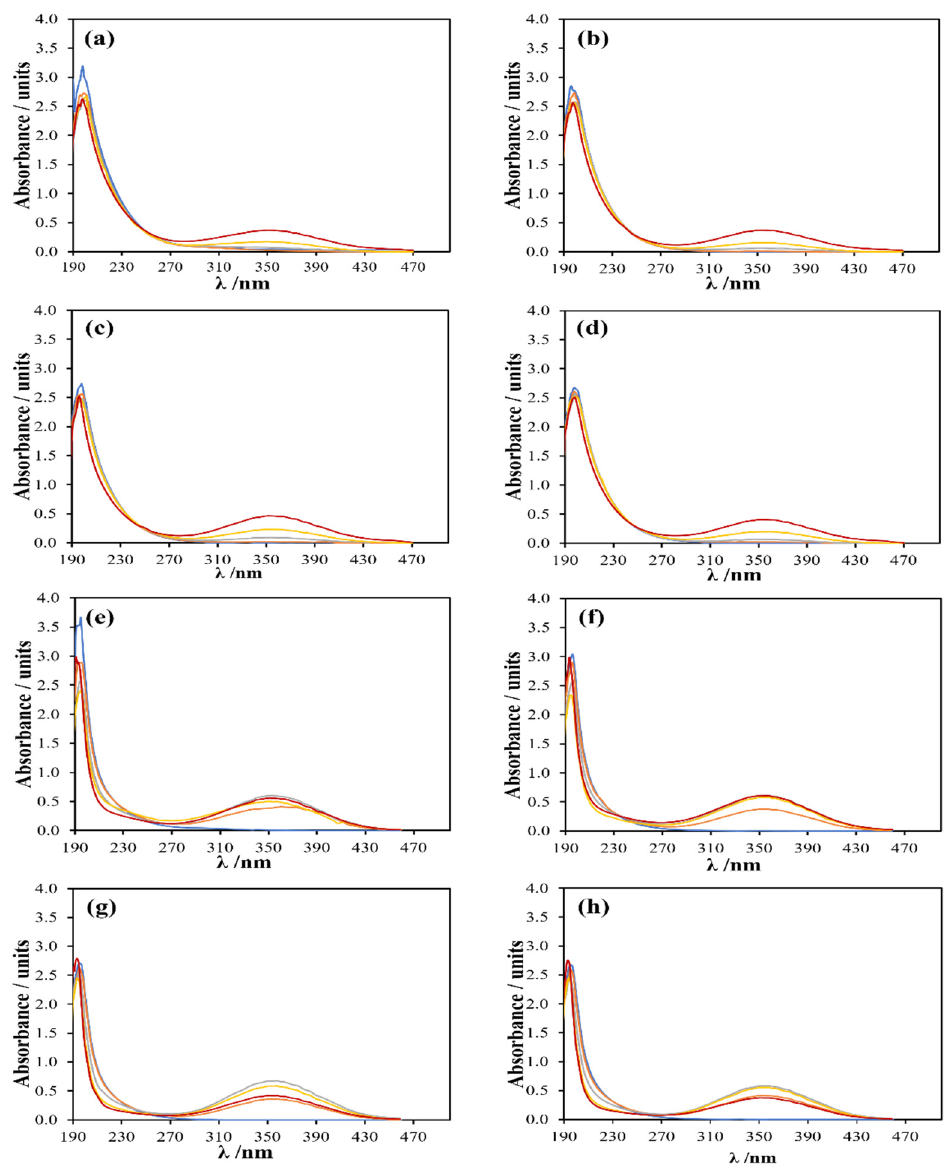
Figure 2. Change in the UV-vis spectra recorded during production of chlorine dioxide in the liquid reaction mixture: ( a – d ) 10 mL of chlorate (5 g L − 1 ), 6 mL of hydrogen peroxide (3300 mg L − 1 ) and 25 mL of sulfuric acid (5.0 M) at 50 °C; ( e – h ) 10 mL of chlorate (5 g L − 1 ), 4 mL of hydrogen peroxide (3300 mg L − 1 ) and 25 mL of sulfuric acid (5.0 M) at 83 °C. Number of repetitions: 4. Legend: ( ▬ ) 0 min, ( ▬ ) 60 min, ( ▬ ) 180 min, ( ▬ ) 420 min and ( ▬ ) 1440 min. 50 °C: ( a ) test Q1, ( b ) test Q2, ( c ) test Q3 and ( d ) test Q4. 83 °C: ( e ) test Q5, ( f ) test Q6, ( g ) test Q7 and ( h ) test Q8.